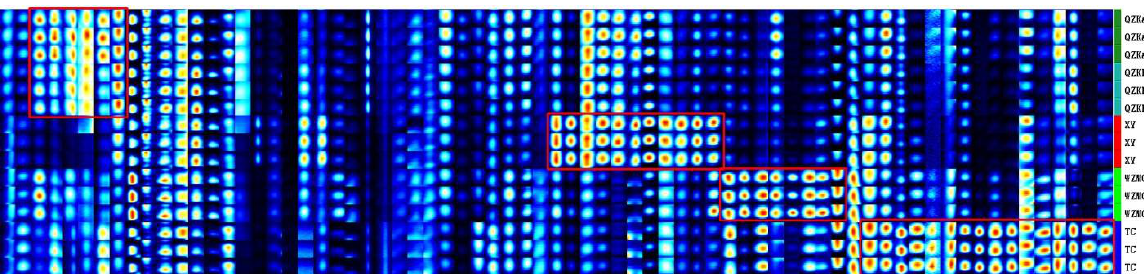
Figure 3. Gallery Plot diagram of volatile compounds in Qu Aurantii Fructus and Aurantii Fructus. Note: each row represents a sample (from top to bottom, 1~6 are Qu Aurantii Fructus, 7~30 are Aurantii Fructus, and 7~12 are Citrus aurantium L., 13~21 are Citrus aurantium cv. Xiucheng, 22~24 are Citrus aurantium ‘Daidai’, 25~27 are Citrus aurantium ‘Chuluan’, and 28~30 are Citrus aurantium ‘Huangpi’); each column represents a compound.